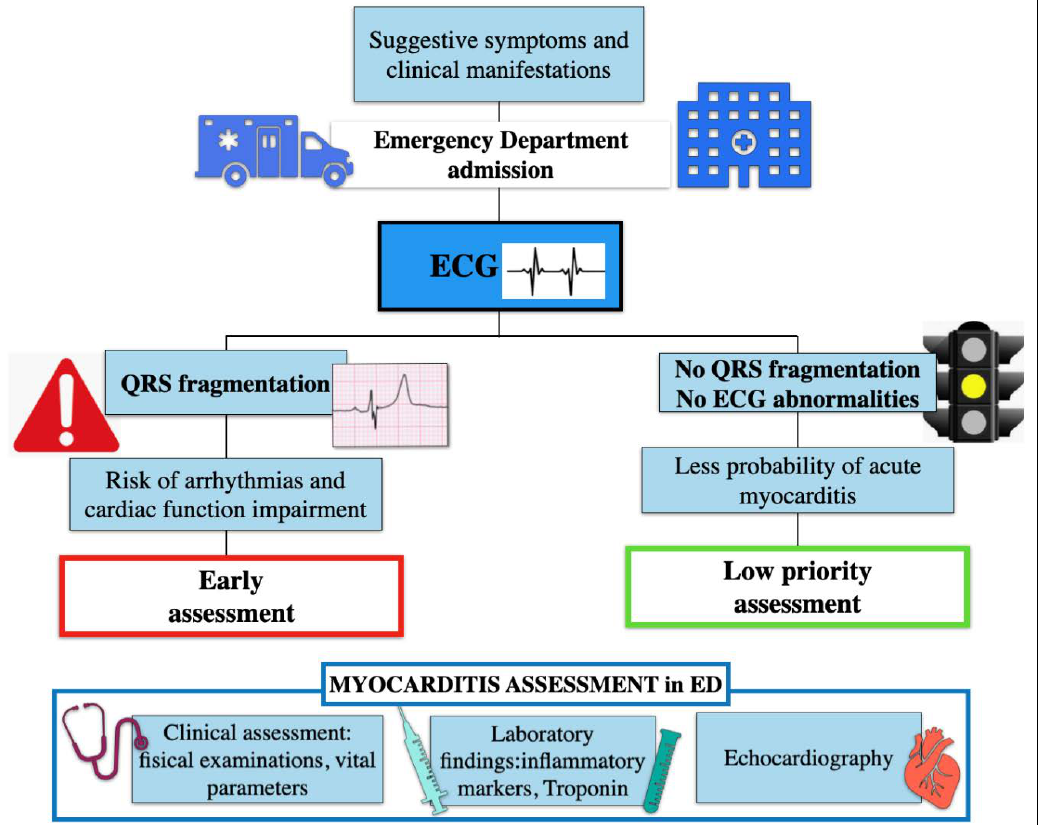
Figure 2. Algorithm assessment of patient with suspected myocarditis in Emergency Department.